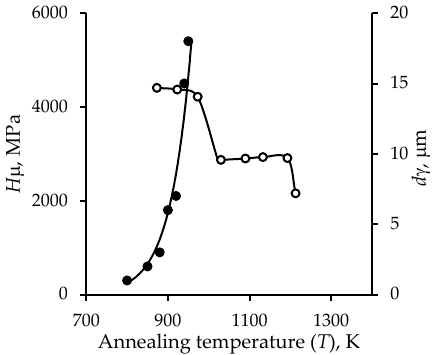
Figure 6. The dependence of the microhardness ( H μ ) on the annealing temperature ( T ) of the studied alloy after the quenching at 1223 K (10 min) and 90% rolling.